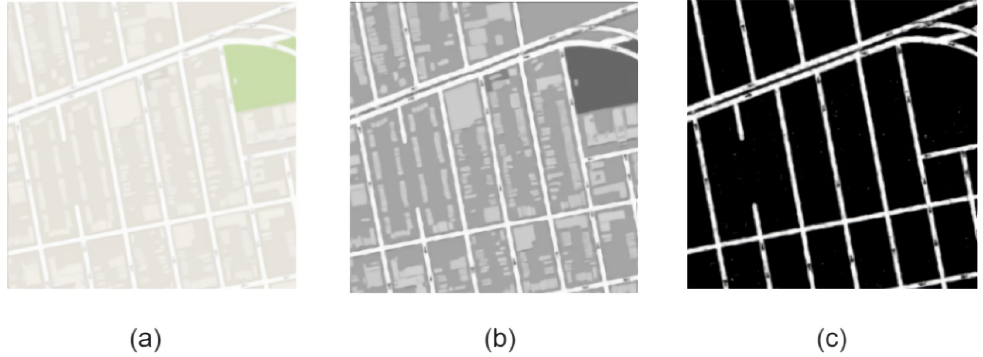
Figure 4. Pre-processing of Pix2Pix images—( a ) initial image of the map ( b ), converting to black and white ( c ), thresholding to obtain the binary